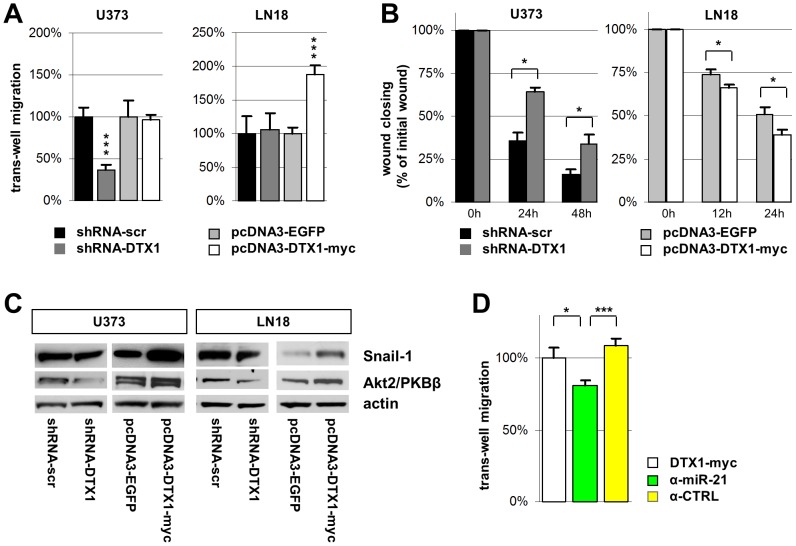
Migration and invasion potential of glioma cells is regulated by DTX1.(A) Boyden chamber trans-well migration and invasion assay with U373 and LN18 glioma cells on collagen coated membranes with 8 µm porosity. Counts were performed after 24h. (B) Scratch test wound healing assay. A scratch wound was inflicted and immediately imaged (time 0h). Follow up images were taken after 12, 24 and 48 hours. Wound closing was assessed using standard imaging software. (C) Western blot analysis of known pro-migratory factors in glioblastoma probing for Snail-1, Akt2/PKBβ, and beta-actin. (D) Boyden chamber trans-well migration assay with U373-DTX1-myc cells not treated (white), treated with a miR-21 inhibitor (α-miR-21, green) or an inhibitor control (α-CTRL , yellow). Average values are shown from at least three individual experiments. Error bars: ±SEM. * p<0.05, *** p<0.001.